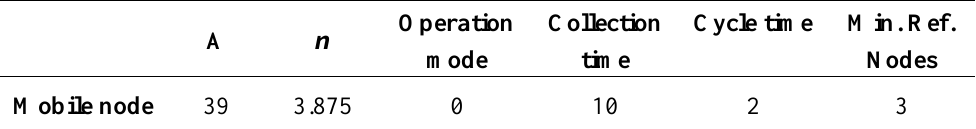
Table 9. The configuration parameters of the mobile nodes.